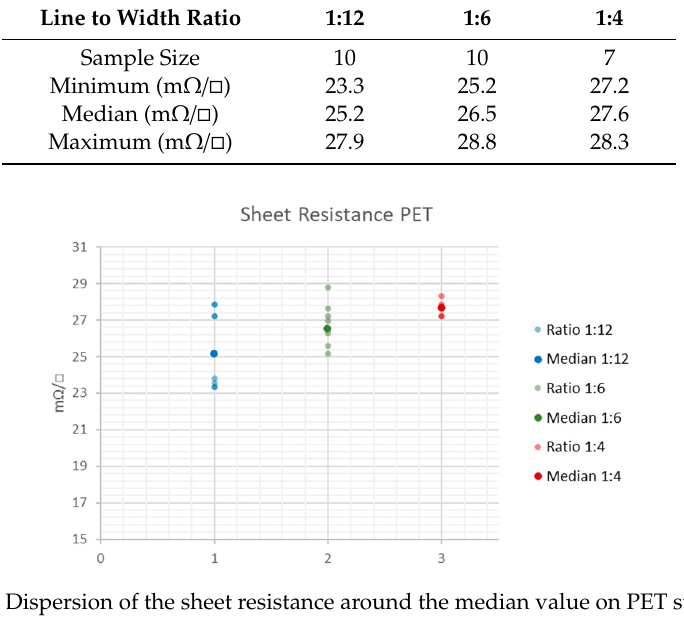
Table 2. statistical key data of the sheet resistance measurement values for the PET substrate.